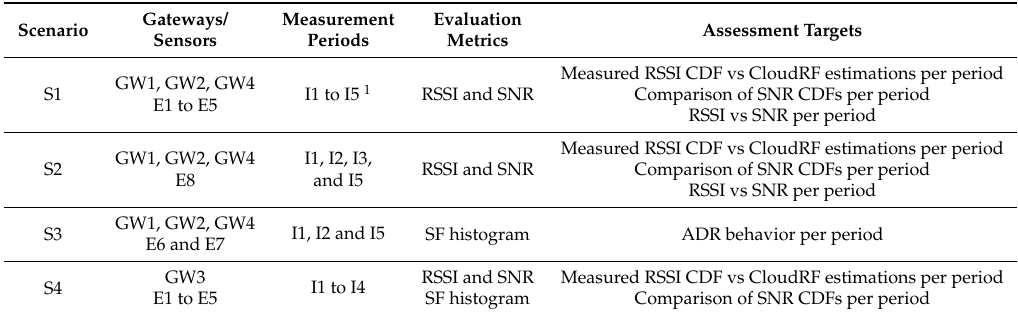
Table 8. Measurement Scenarios (gateways, sensors, periods, metrics and assessment